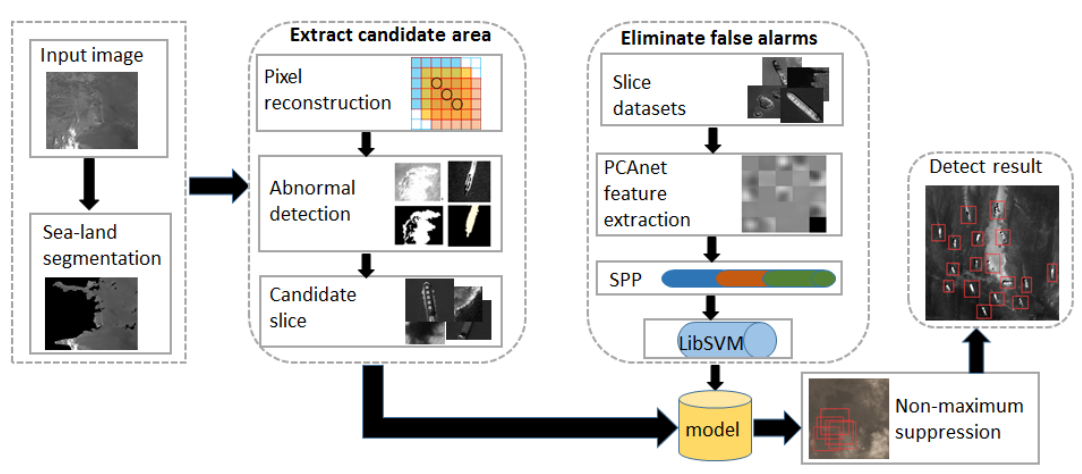
Figure 1. The overall flow chart of target detection. The process from left to right are sea–land segmentation, candidate area extraction, false alarm exclusion, and detection